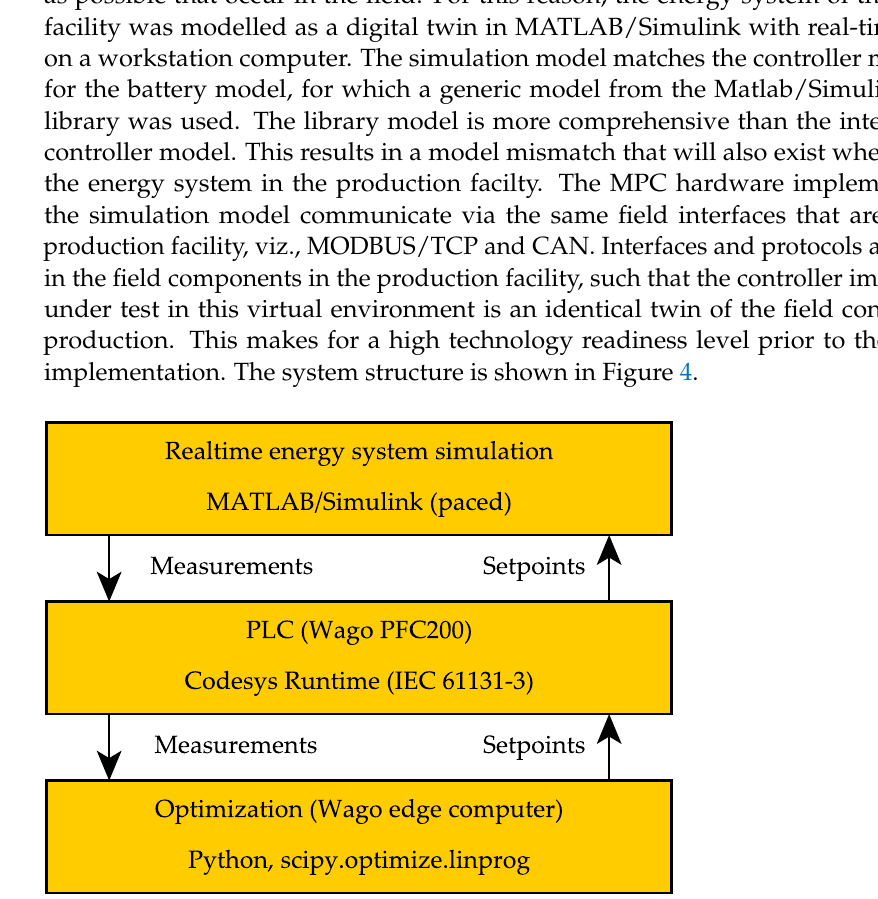
Figure 4. Hardware and Software components of the MPC control solution: HiL model, PLC, and